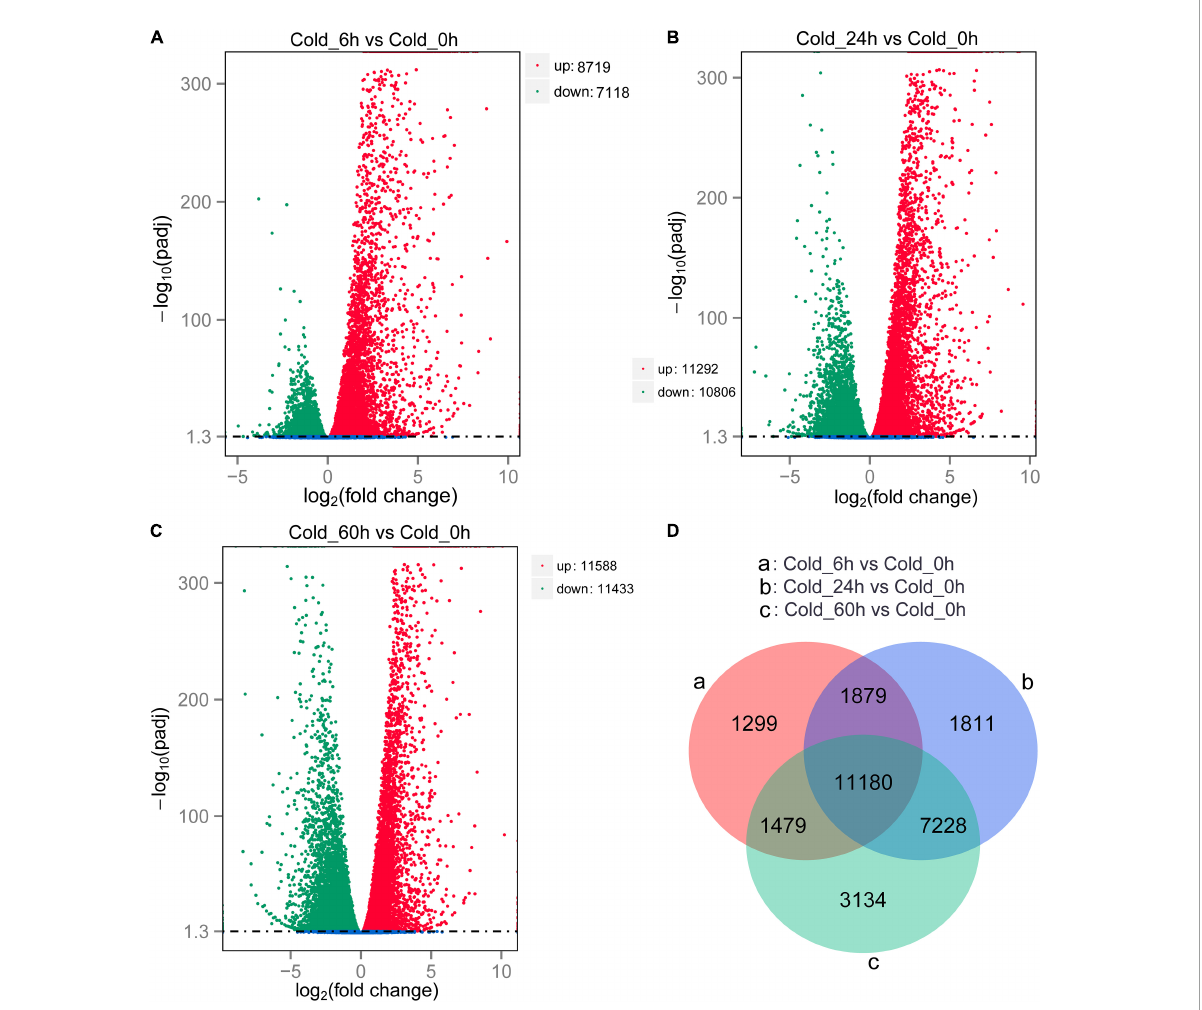
FIGURE5 Differentially expressed genes screening and Venn diagram analysis (A–C) . The volcano plot showing the DEGs between cold stress group and control group. The X-axis indicates fold change of gene expression (threshold, | log 2 (Treat/Control)| > 0), while the Y-axis means the statistically significant level (threshold, log10(padj) > 1.3). (D) Venn diagram shows the DGEs distribution among different compare